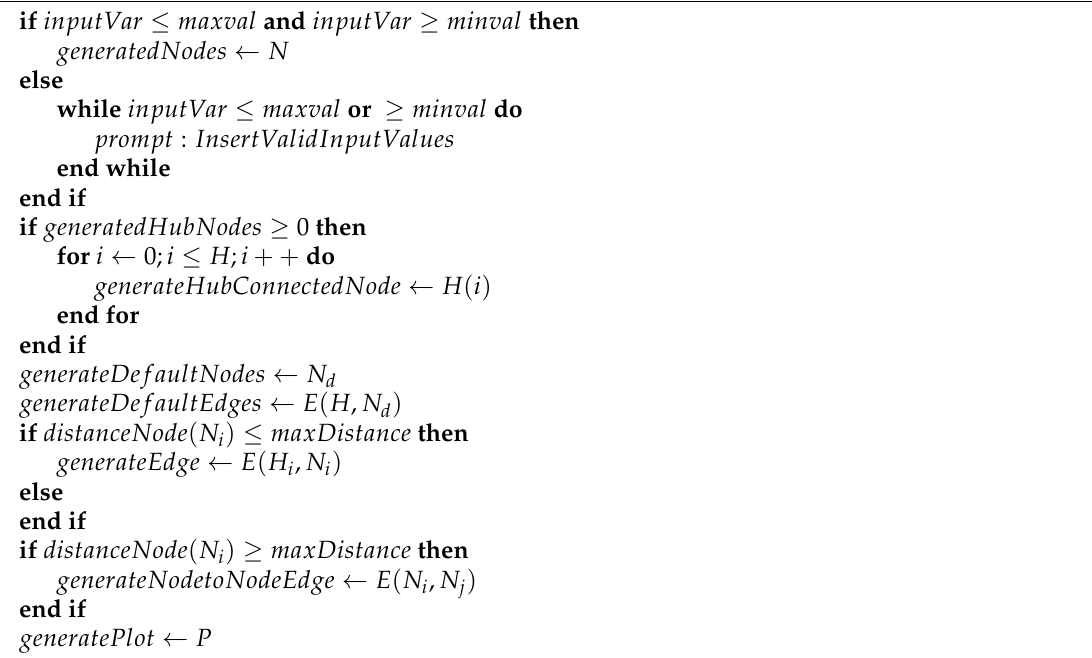
Algorithm 1 Graph generation algorithm